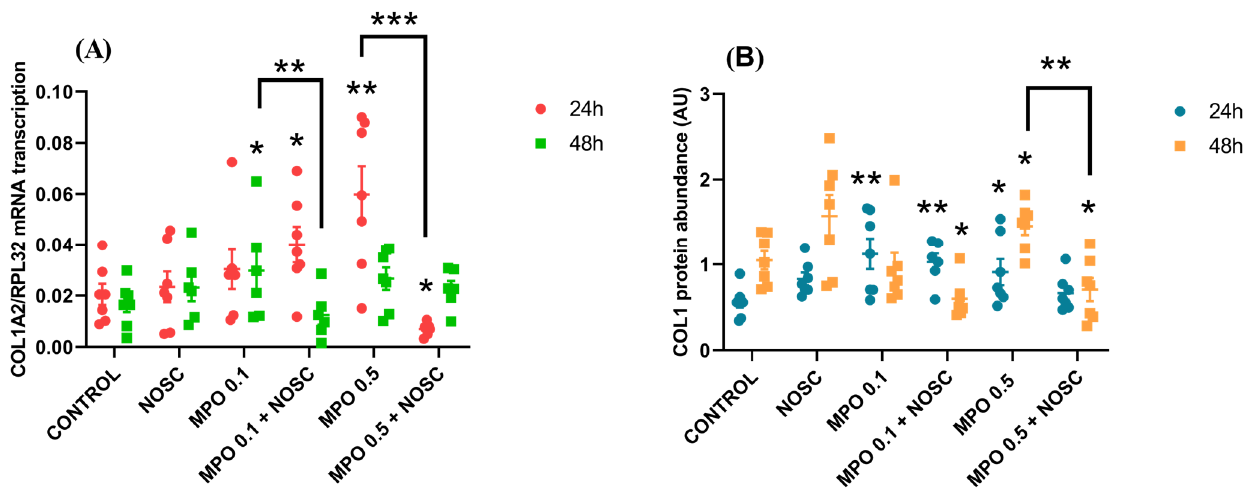
Figure 4. Effect of myeloperoxidase (MPO; 0.1–0.5 µ g/mL), noscapine (NOSC; 45 µ g/mL), or MPO (0.1–0.5 µ g/mL) + NOSC (45 µ g/mL) treatments in explants of mare endometrium from the follicular phase (FP; n = 7), treated for 24 or 48 h, on relative collagen type I alpha 2 chain ( COL1A2 ) mRNA transcription ( A ) and collagen type I (COL1) protein relative abundance ( B ). Results were considered significant at p < 0.05 and shown in a scattered dot plot, as the mean ± SEM. Asterisks represent significant differences relative to the respective control and asterisks above connecting lines indicate significant differences of MPO + NOSC treatment relative to the respective MPO-treated group (* p < 0.05; ** p < 0.01; *** p < 0.001).